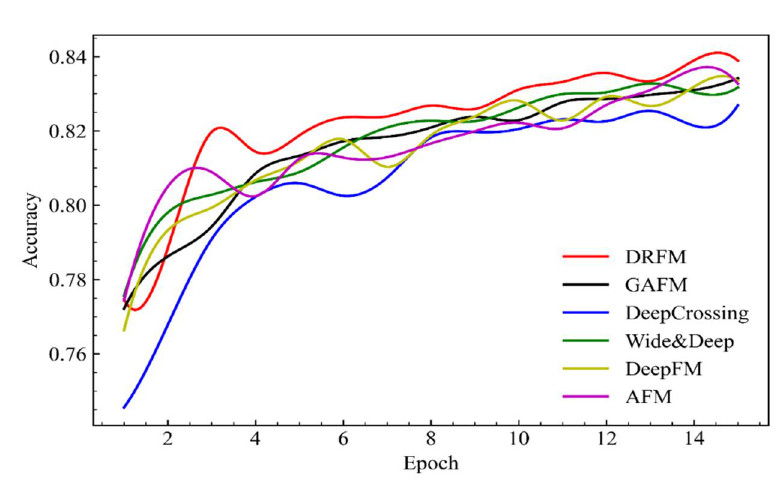
Figure 8. Accuracy of each model on dataset 2.